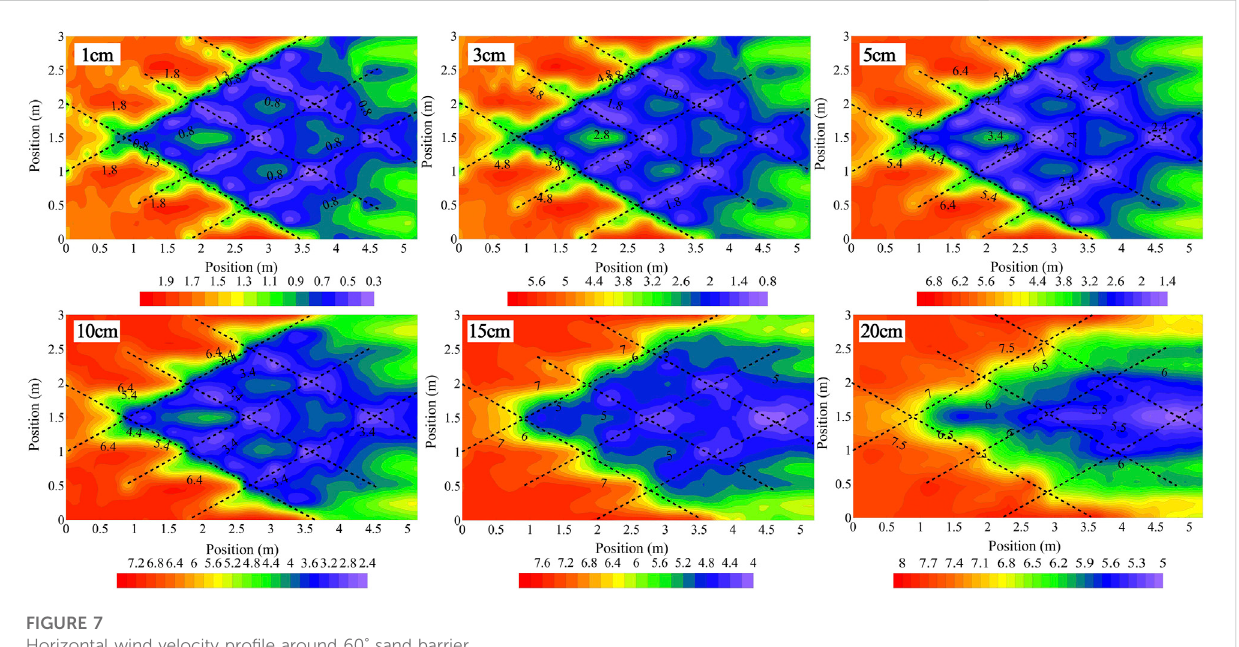
FIGURE 7 Horizontal wind velocity pro fi le around 60 ° sand